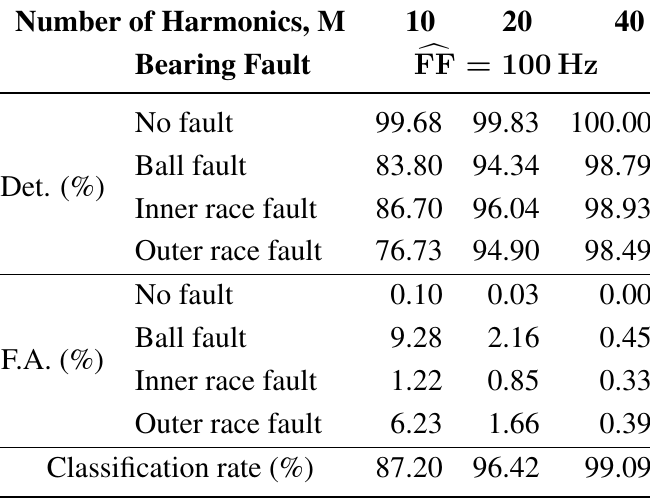
Table 3. Bearing fault single-event detection, false alarm and classification rates, from